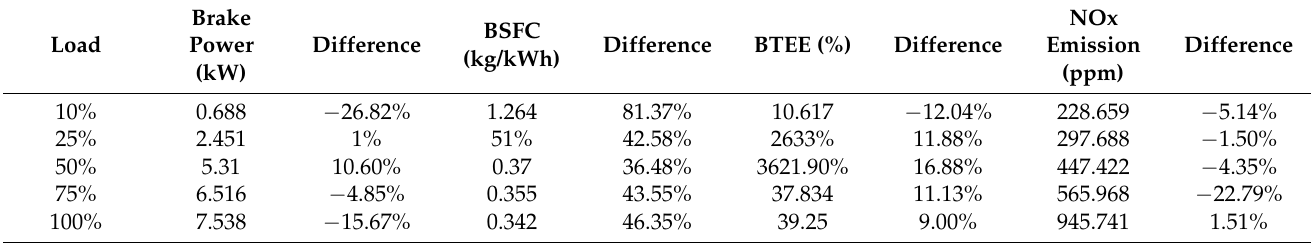
Table 6. Results of ethanol engine with diesel cycle and the difference between the diesel